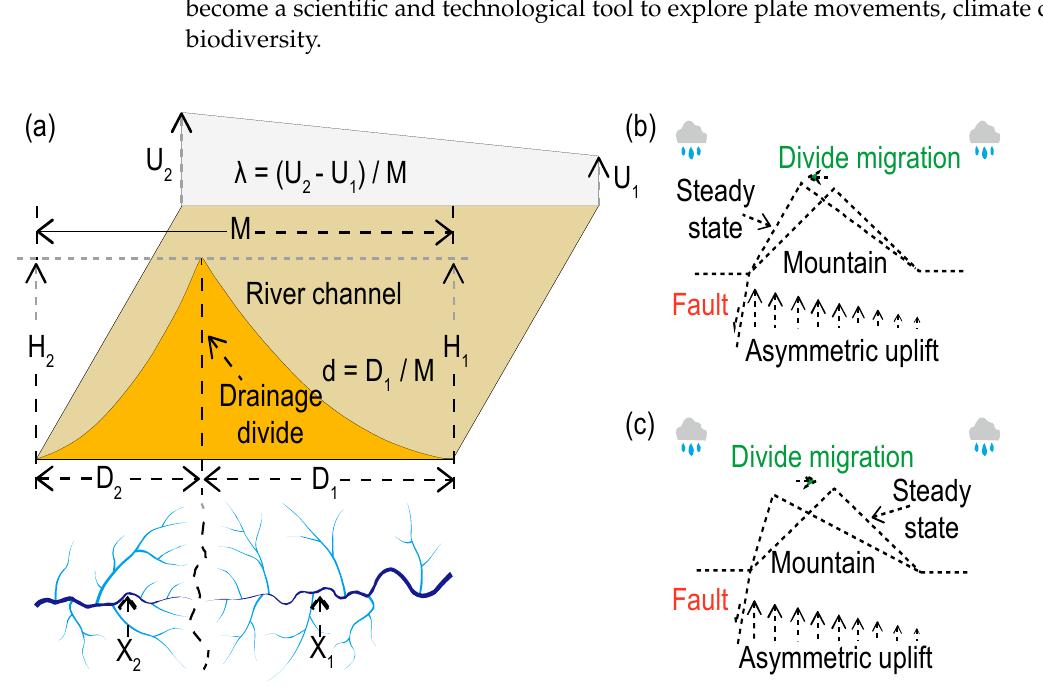
Figure 10. Drainage divide migration modified from [86,87]. ( a ) drainage divide, U 1, and U 2 are the uplift rates on both sides of the mountain belt, and D 1 and D 2 are the horizontal distances from the drainage divide to both sides, respectively. X 1 and X 2 are the upstream distances of the channel along the divide-normal direction, respectively. M is the mountain width. H 1 and H 2 are the channel heights above the base levels. λ and d are the gradients of the uplift rate and divide location, respectively. ( b , c ) are the migration of the drainage divide.